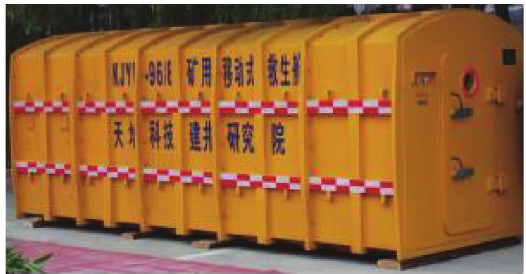
Figure 3: Moveable rescue chamber